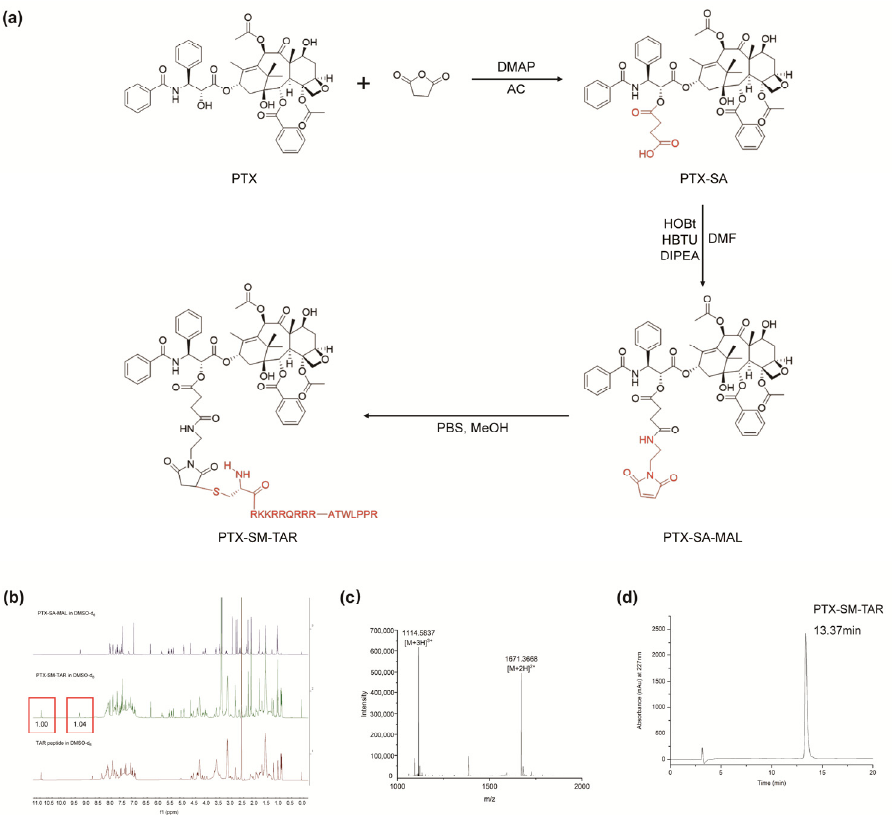
Figure 2. Synthesis and characterization of PTX-SM-TAR. ( a ) Synthetic route of PTX-SM-TAR. ( b – d ) 1 H-NMR, Q-TOF HRMS, and HPLC spectrum of PTX-SM-TAR